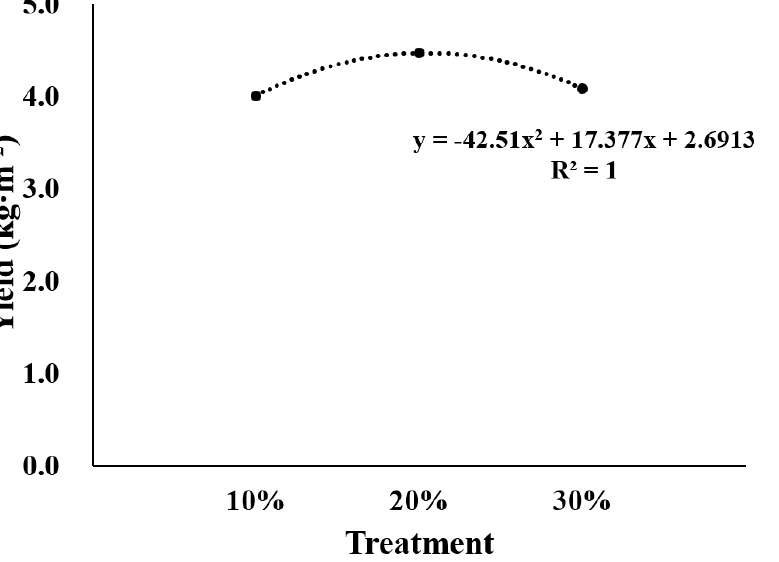
Figure 7. Fruit yield with superior quality (above 27 g) harvested from strawberry ‘Kuemsil’ affected by the nutrient solution supplying system using different drainage rate levels and timings (Drainage rate 10%, 20%, or 30%; Timer 1, timer set for 4 applications daily; Timer 2, timer set for six applications daily). Vertical bars indicate standard errors of the means ( n = 3).